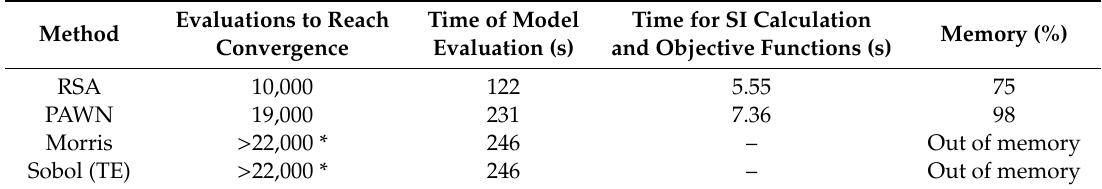
Table 3. Number of evaluations and computing costs associated with performing a single sensitivity analysis using di ff erent